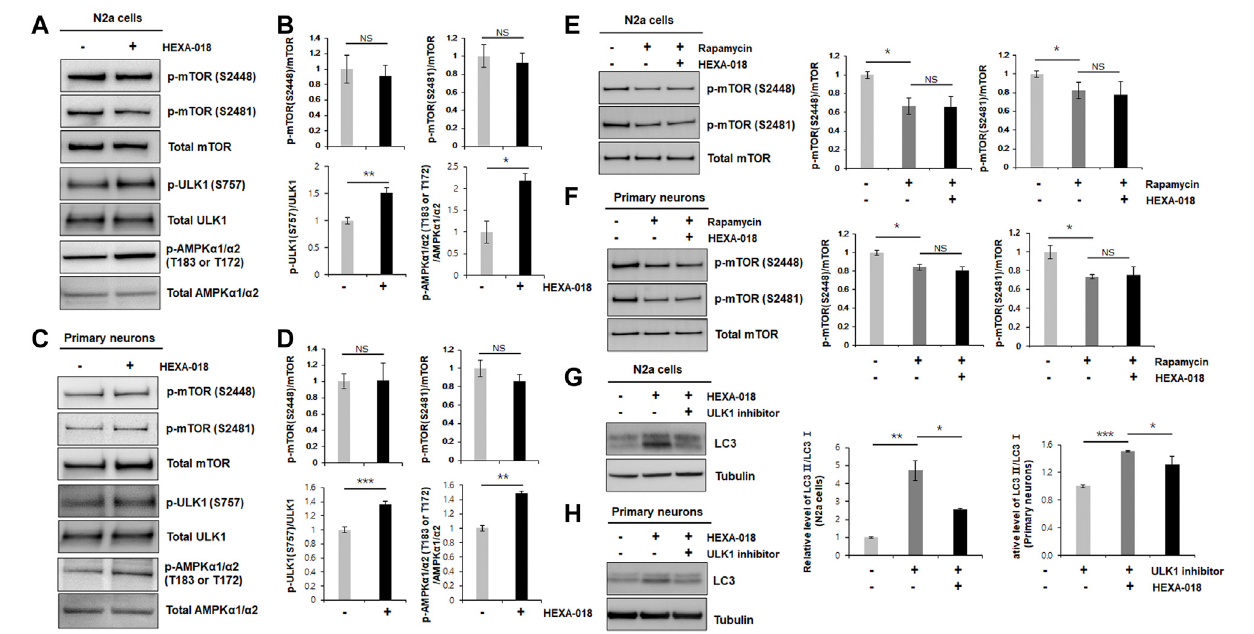
FIGURE 2 | HEXA-018 is an mTOR-independent activator of the ALP. (A,B) N2a cells were treated with HEXA-018 (5 µM) for 24 h, and then, the cells were harvestedfortotalprotein extraction. Western blotanalysiswasperformedtodeterminephospho-mTOR(S2481orS2488),totalmTOR, phospho-ULK1(S757),ULK1, p-AMPK α 1/ α 2 (T183 or T172), or AMPK α 1/ α 2 protein expression. Quanti fi cation of the immunoblots was performed from 3 independent experiments. Treatment with HEXA-018 did not affect phospho-mTOR levels but phospho-ULK1 and phospho-AMPK protein levels was signi fi cantly increased in N2a cells. * p < 0.05; ** p < 0.005; n. s. , not signi fi cant (unpaired Student ’ s t -test). (C,D) Primary neurons were treated with HEXA-018 (0.5 µM) for 24 h, and then, the cells were harvested for total protein extraction. Western blot analysis was performed to determine phospho-mTOR (S2481 or S2488), total mTOR, phospho-ULK1 (S757), ULK1, p-AMPK α 1/ α 2 (T183 or T172), or AMPK α 1/ α 2 protein expression. ** p < 0.005; *** p < 0.001; n. s. , not signi fi cant (unpaired Student ’ s t -test). (E,F) N2a cells and primary neurons were pretreated with HEXA-018 (5 µM/0.5 µM) for 30 min and subsequently treated with rapamycin (200 nM) for 24 h, and then, the cells were harvested for total protein extraction. Western blot analysis was performed to determine phospho-mTOR (S2481 or S2488) or total mTOR protein expression. HEXA-018 treatment was not signi fi cantly changed following rapamycin-decreased phospho-mTOR levels in N2a cells and primary neurons. Data are presented as the mean ± SD of 3 independent experiments.* p < 0.05; n.s. ,notsigni fi cants(one-wayANOVAwithTukey ’ smultiplecomparisontest). (G,H) N2acellswerepretreatedwithHEXA-018(5 µM)for30 min and subsequently treated with ULK1 inhibitor (200 nM) for 24 h, and then, the cells were harvested for total protein extraction. Western blot analysis was performed